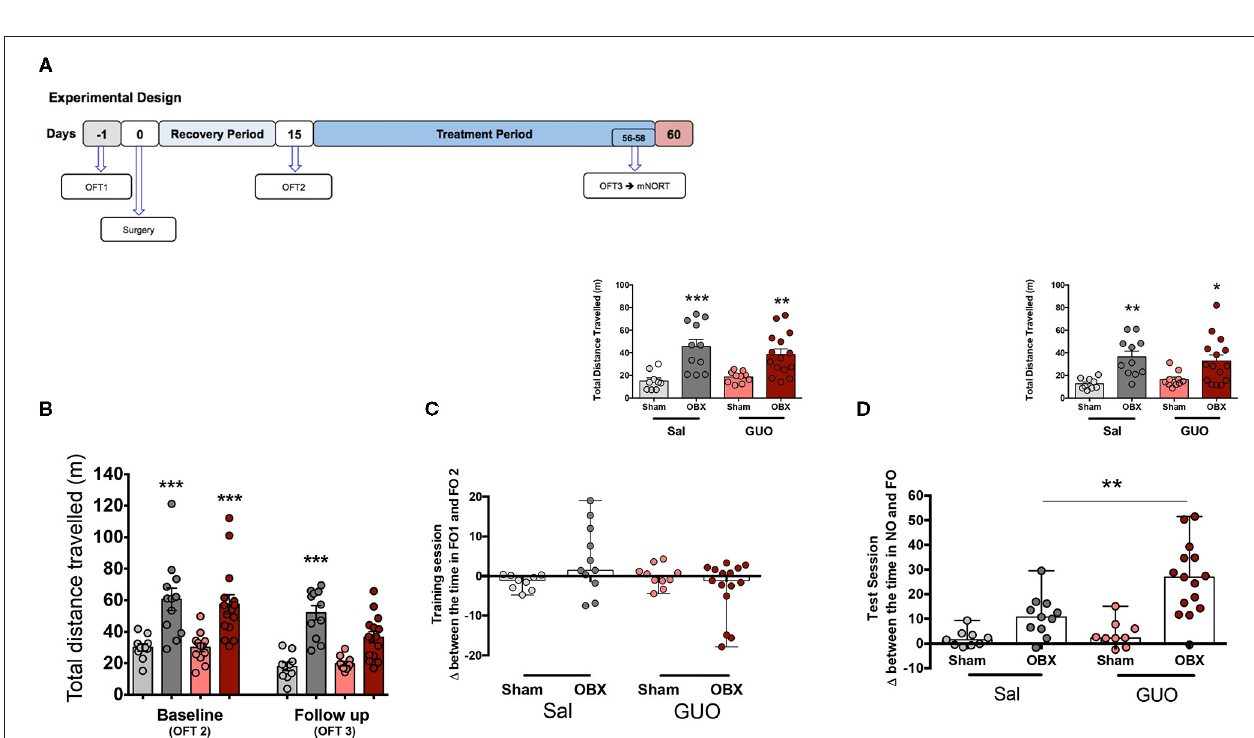
FIGURE 1 | ANOVA/Tukey. (E,F) : Total distance travelled (E) and time spent in each arm (F) in YMT. Columns represent mean ± S.E.M. ( n = 8–14). * p < 0.05, ** p < 0.01, one-way ANOVA/Tukey. Hippocampal levels of BDNF (G) , NO (H) , DCFH (I) , GSH (J) , IL-1 (K) , IL-6 (L) , IL-10 (M) , TNF- α (N) , (O) and INF- γ . Columns represent